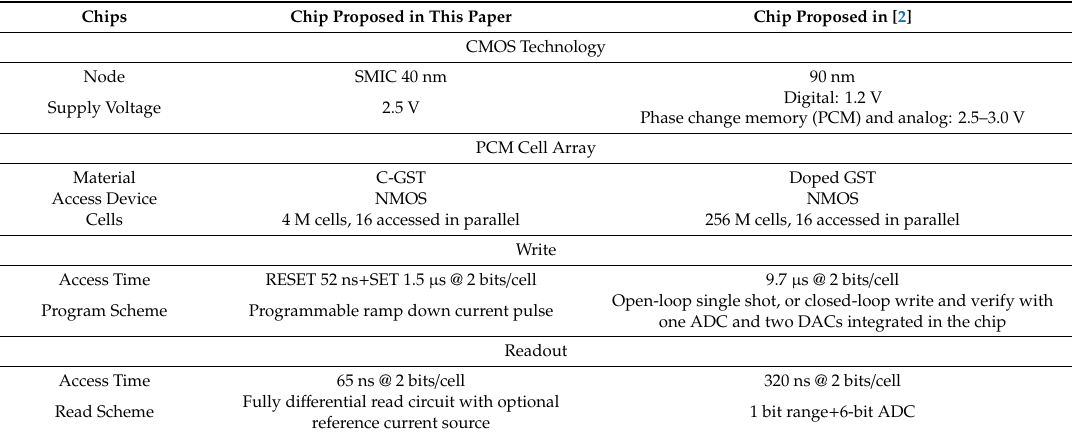
Table 1. Summary of the chips proposed in this paper and